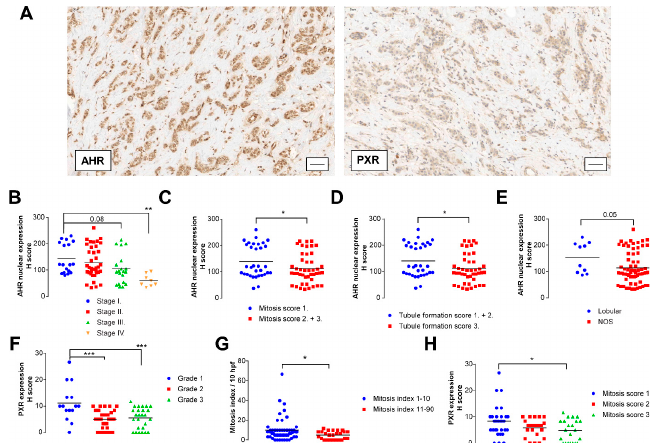
Figure 8. Higher intratumoral expression of pregnane X receptor (PXR) and nuclear aryl hydrocarbon receptor (AHR) shows correlation with low-grade and lower-mitosis breast cancers. ( A ) TMA was stained with the indicated antibodies. A typical staining pattern is shown. The bar is equivalent of 50 μ m. Cases in TMA were scored for receptor expression using the H-score system. ( B – E ) H-score of the nuclear expression of the AHR receptor were related to ( B ) stage of the disease, ( C ) mitosis score, ( D ) tubule formation, and ( E ) histological subtype. ( F – H ) H-score of the expression of PXR receptor were related to ( F ) grade of the disease, ( G ) mitosis score, and ( H ) mitotic index. Statistical significance on panels B and F was determined using an ANOVA test followed by Dunnett’s post-hoc test, while on panels C, D, E, G, and H, Student’s t -test was used. Stage 0 (in situ carcinoma) and stage 1